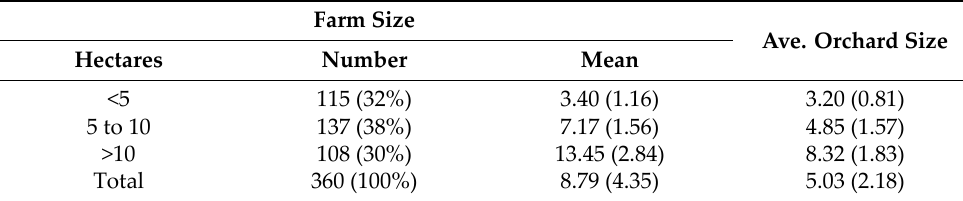
Table 1. Descriptive statistics of mandarin farmers by farm and orchard